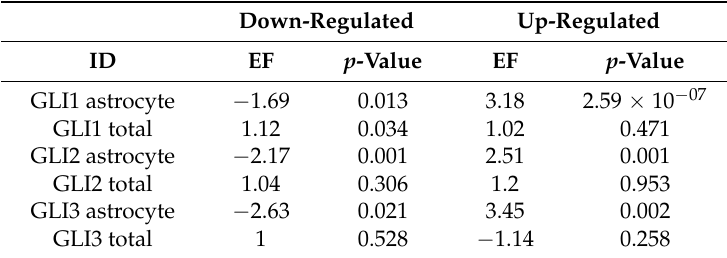
Table 8. Signature analysis of targets of GLI transcription factors in